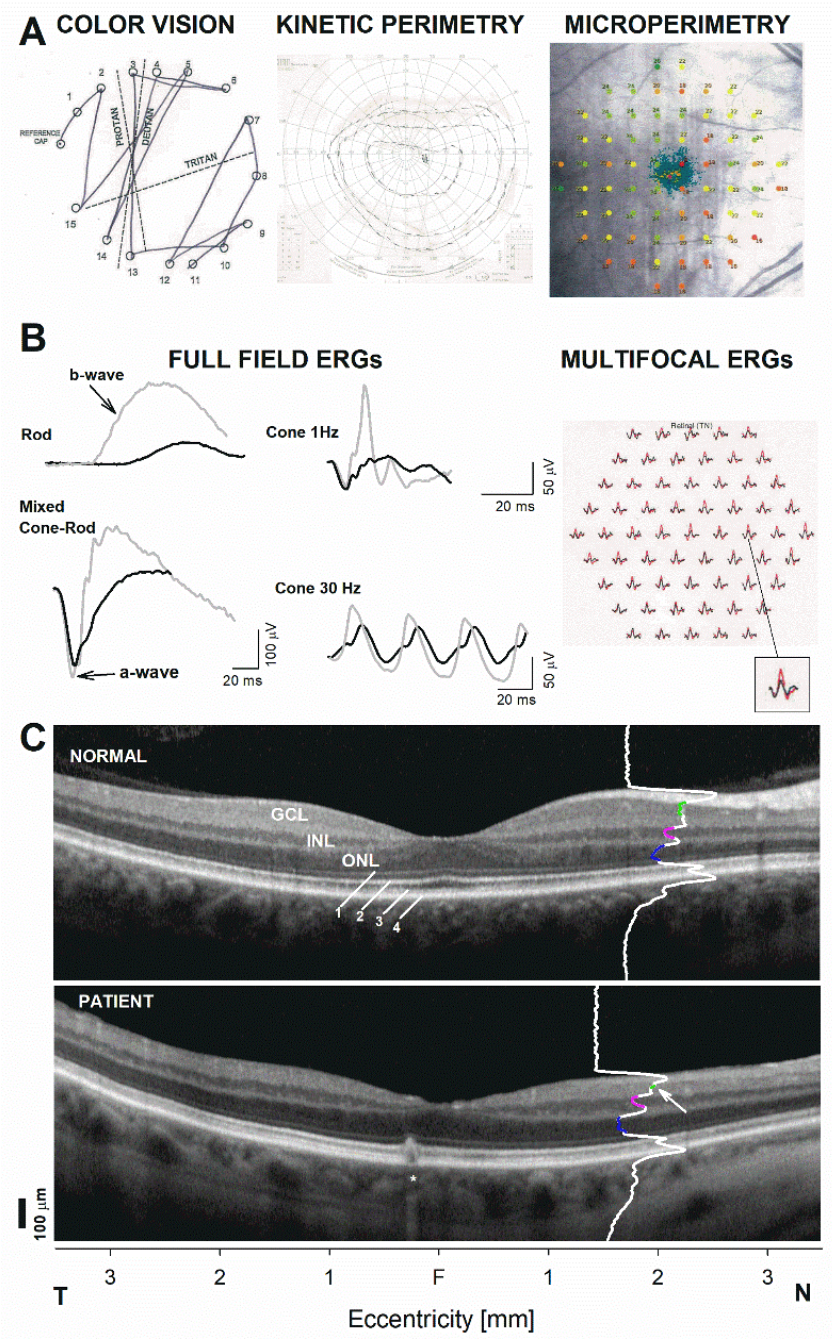
Figure 3. Detailed functional and structural phenotyping of the WDR36 -positive patient using color vision and perimetric functional analysis, followed by electrophysiology. Only one eye is shown for clarity; results are nearly identical in the contralateral eye. ( A ) Left panel: color vision documented with a Farnsworth–Munsell D15 test; middle panel: Goldman kinetic perimetry to three stimulus conditions (V-4e, III-4e and I-4e); right panel: dark-adapted (>30 min), fully dilated fundus perimetry or microperimetry (MAIA, CenterVue, Padova, Italy) from our patient. Sensitivities are shown as numerical values next to the testing (a 68 point, conventional ‘10-2 protocol’ grid), as well as color-coded sensitivity losses compared to a normative database (green symbols, ≥ 25 dB, considered a rough lower limit of normal across the grid). Blue-green traces near the center portray prefer locus and fixation excursions. ( B ) Standard electroretinography elicited using a commercially available system (Espion e3, Diagnosys LLC, Lowell, MA, USA). Standard full-field electroretinograms